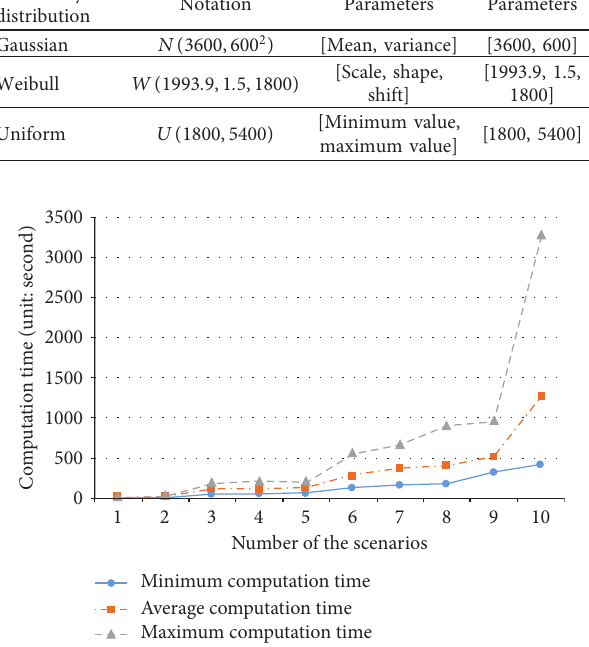
Figure 6: Influence of the number of scenarios on computation